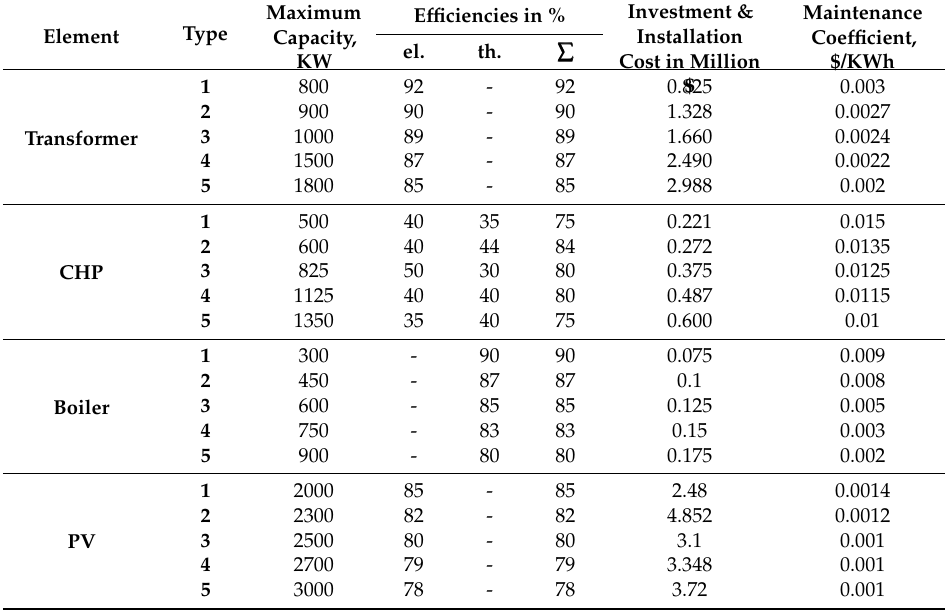
Table 1. Technical specification of the candidates.